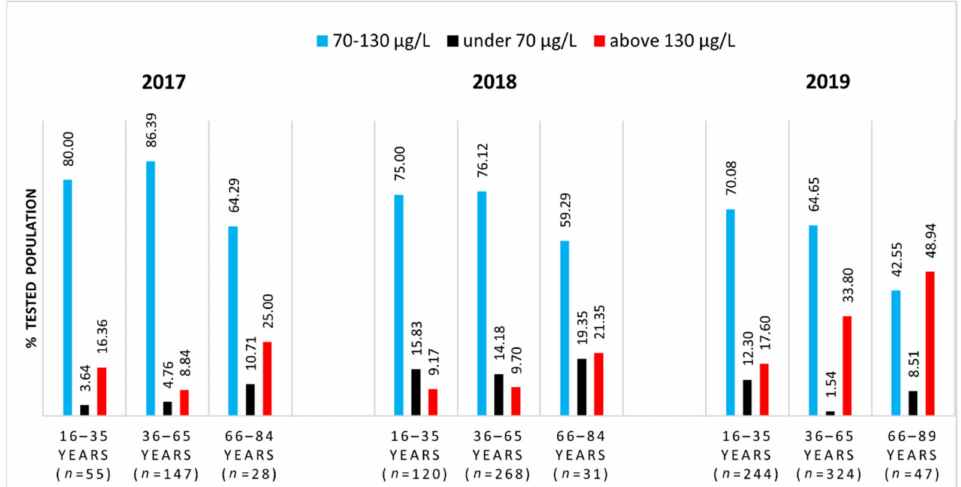
Figure 2. Distribution of tested population according to the SeS reference range of 70–130 µ